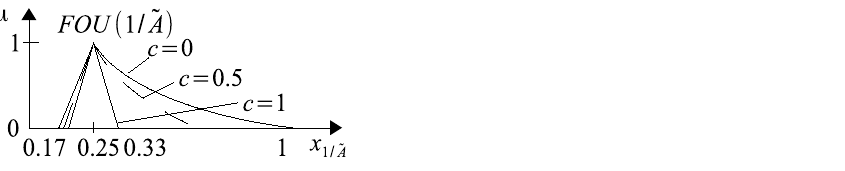
Figure 25. FOU ( 1/ ˜ A ) or cuts of the inverse T2FN 1/ ˜ A for various confidence c